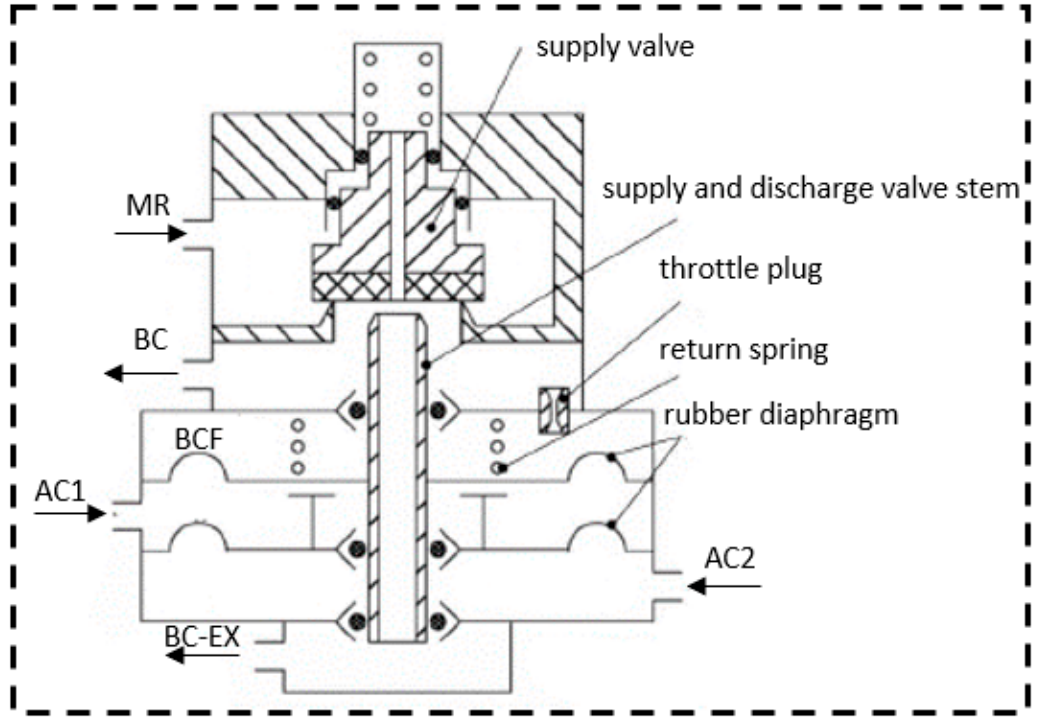
Figure 2. Relay valve structure.